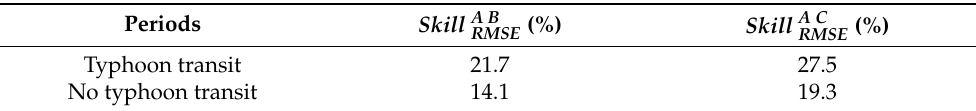
Table 3. Mean of Skill A B and Skill A C RMSE for typhoon transit or no typhoon transit in April, September, and October 2021.